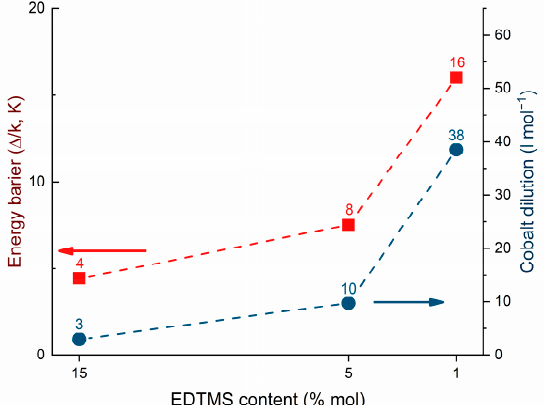
Figure 11. Magnetic dilution in aerogel-based cobalt SIM materials: cobalt atoms can be effectively dispersed in an aerogel matrix by lowering the EDTMS ligand content, thereby increasing the magnetic relaxation energy barrier.